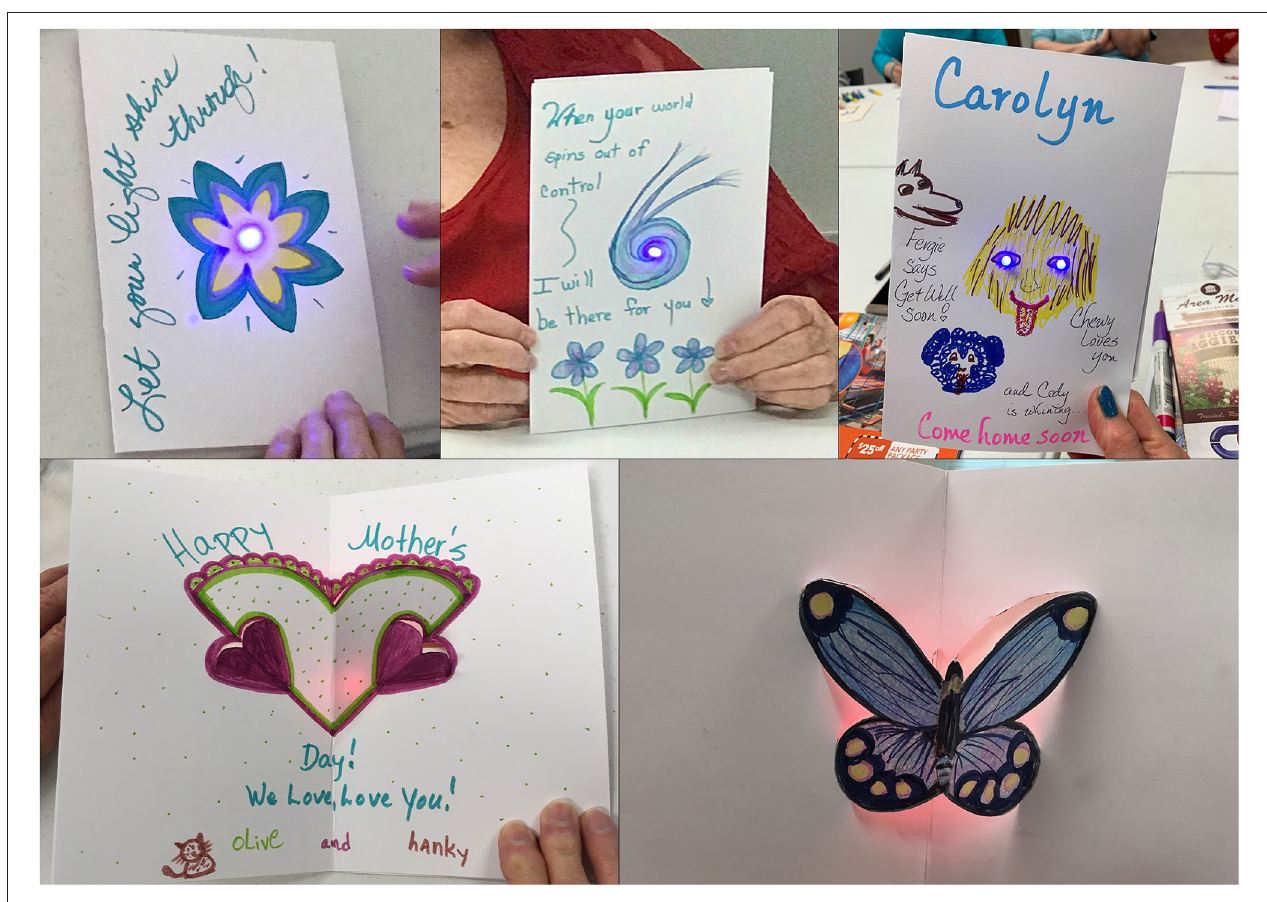
FIGURE 2 | Light-up cards and pop-up cards created by